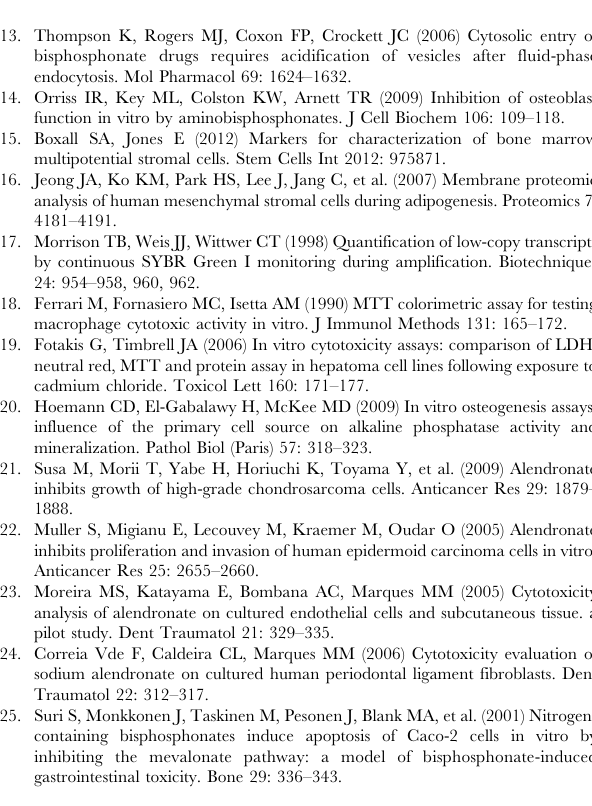
Figure S1 Isolated hBMSCs were identified by surface markers and multi-potent differentiation potential. (A) Isolated hBMSCs were identified by CD markers that measured by flowcytometry using specific antibody against CD29, CD34, CD45, CD49d, CD90 and CD166. The white diagram indicated CD marker positive population and the red diagram indicated non-specific antibody control. (B) Isolated hBMSCs were induced to osteogenesis, chondrogenesis or adipogenesis by induction medium. Alcian blue, ARS or oil red staining was for sGAG, mineralization or oil droplet, respectively. Figure S2 Aln increases osteogenic gene expressions and ALP activity in hBMSCs. (A) The mRNA expression of BMP-2, Runx-2 and osteocalcin in 5 m M Aln-treated hBMSCs were measured at day 5 and 7. The treatment strategy was shown in Figure 1. Cultured hBMSCs were untreated (control) or treated with 5 m M in the first 5 days in bone medium (grey bars; Group A) or the second five days in osteo-induction medium (black bars; Group B). ** p , 0.01, n= 3; * p , 0.05, n= 3, compared with control group. ## p , 0.01, n =3; # p , 0.05, n = 3, compared with group A. (B) The ALP activities of Aln-treated hBMSCs were measured at day 15 with control group, group A, and group B.